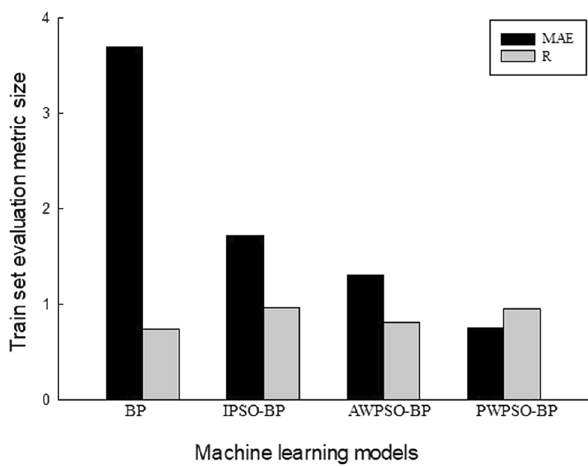
Figure 15. Performance evaluation index of the algorithm model of the right training set.